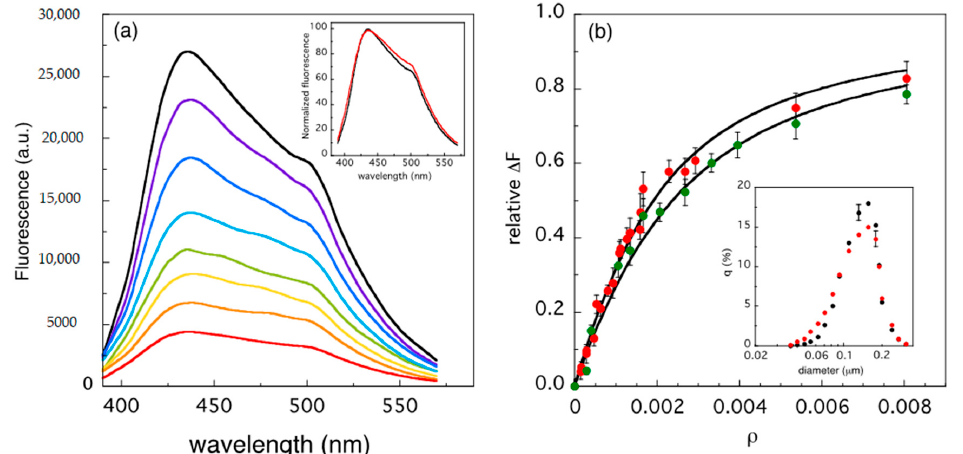
Figure 5. ( a ) Laurdan fluorescence as a function of ρ (black line: ρ = 0; red line: ρ = 0.008); in the inset, the initial (black) and final (red) normalized spectra are reported; ( b ) normalized total fluorescence change of wild type-cyt c (red) and K72N-mutate cyt c (green) as a function of ρ . Solid lines correspond to the best fits (described in Materials and Methods), which yield the dissociation constant values K d WT = (0.18 ± 0.03)·10 − 6 M and K d K72N = (0.24 ± 0.03)·10 − 6 M, and the number of lipids interacting with each protein molecule N L WT = (21 ± 7) and N L K72N = (24 ± 8), respectively. In the inset, the size distribution of the LUVs obtained by light scattering is reported, in the absence (black points) and in the presence (red points) of wt-cyt c. A representative error bar has been included in each dataset.